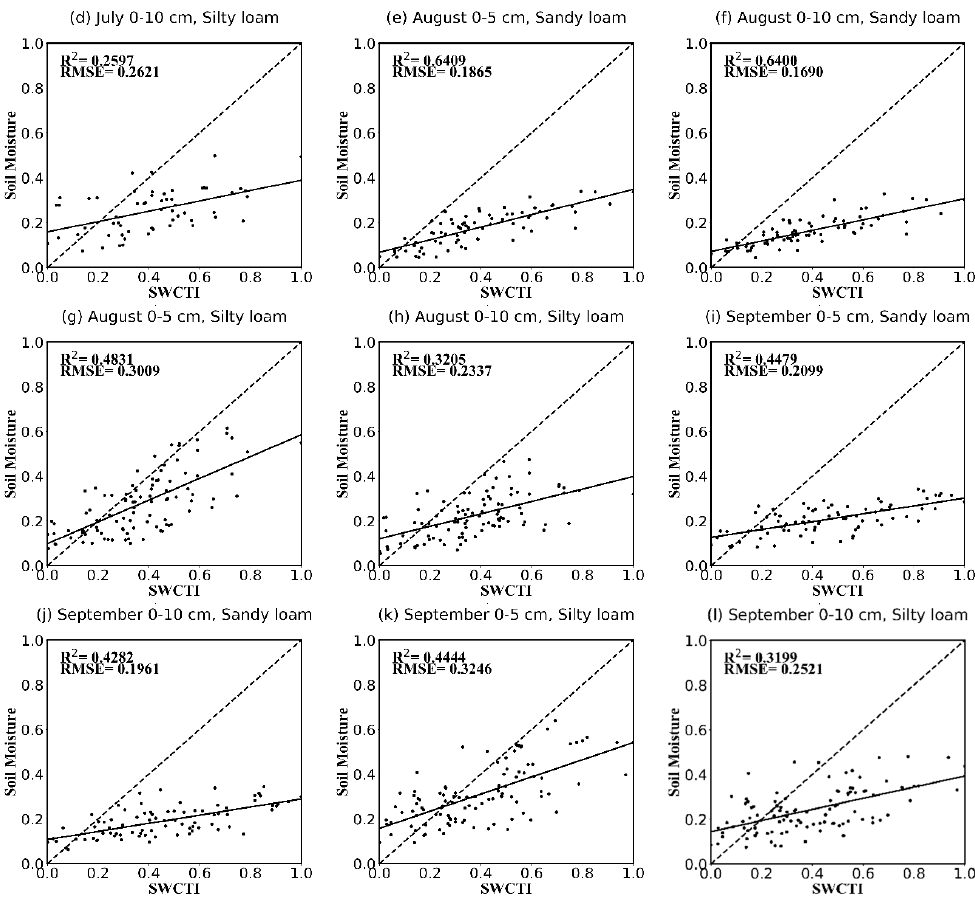
Figure 11. Scatterplots of SWCTI vs. in situ soil moisture for different soil depths and soil textures and different months. ( a – l ) are the scatterplots for the soil depths of 0–5 cm and 0–10 cm, the soil textures of sandy loam and silty loam, the months of July, August and September,